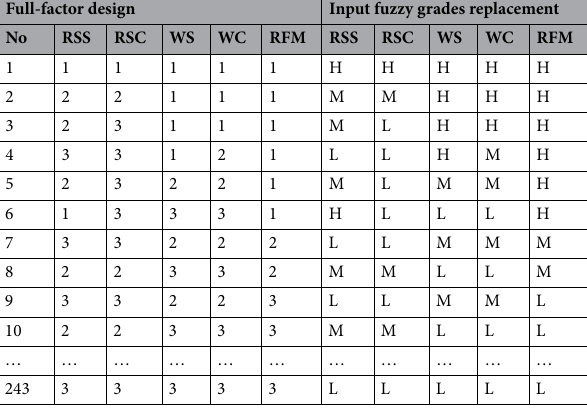
Table 12. The full-factor design based on optimization objectives and fuzzy subset grades of input.